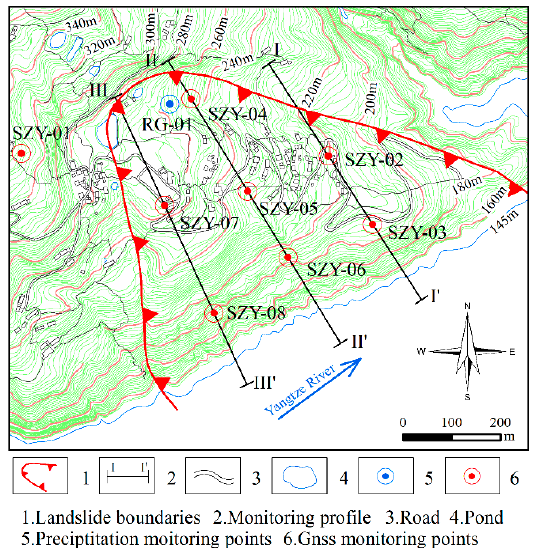
Figure 4. Layout plan of the Shuizhuyuan landslide monitoring network.